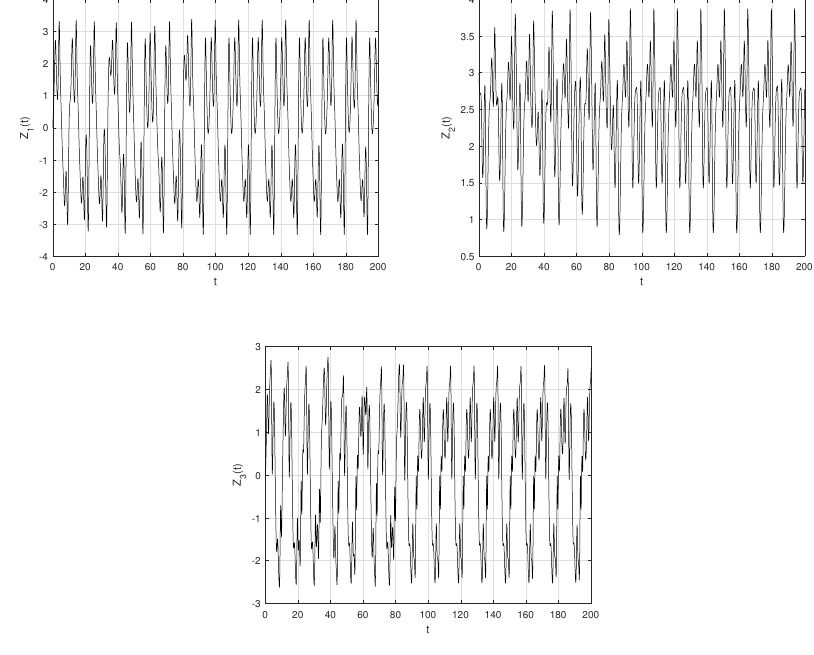
Figure 1. State trajectories of